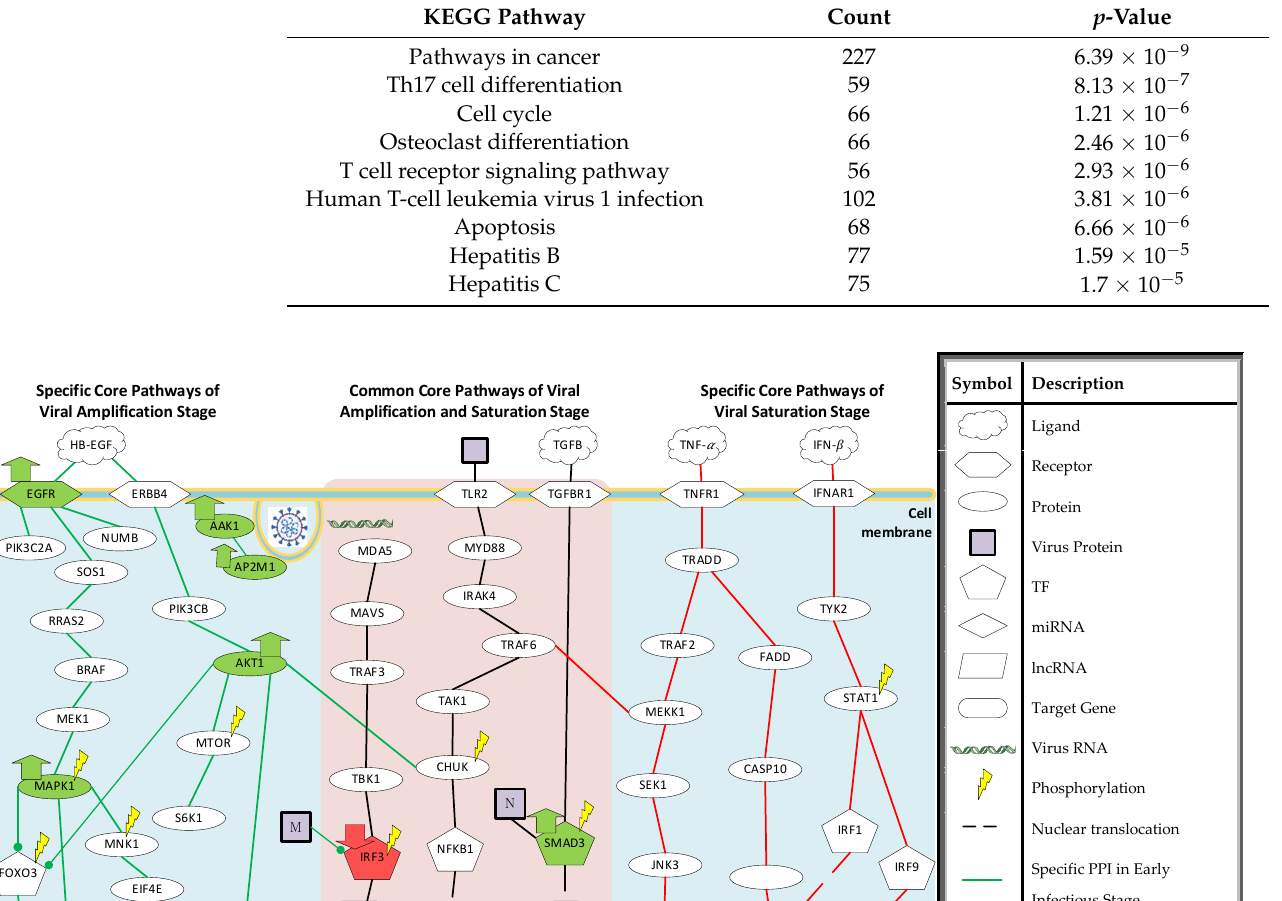
Table 3. The enrichment analysis of KEGG pathways for core HPI-GWGEN of the saturation infec- tious stage.